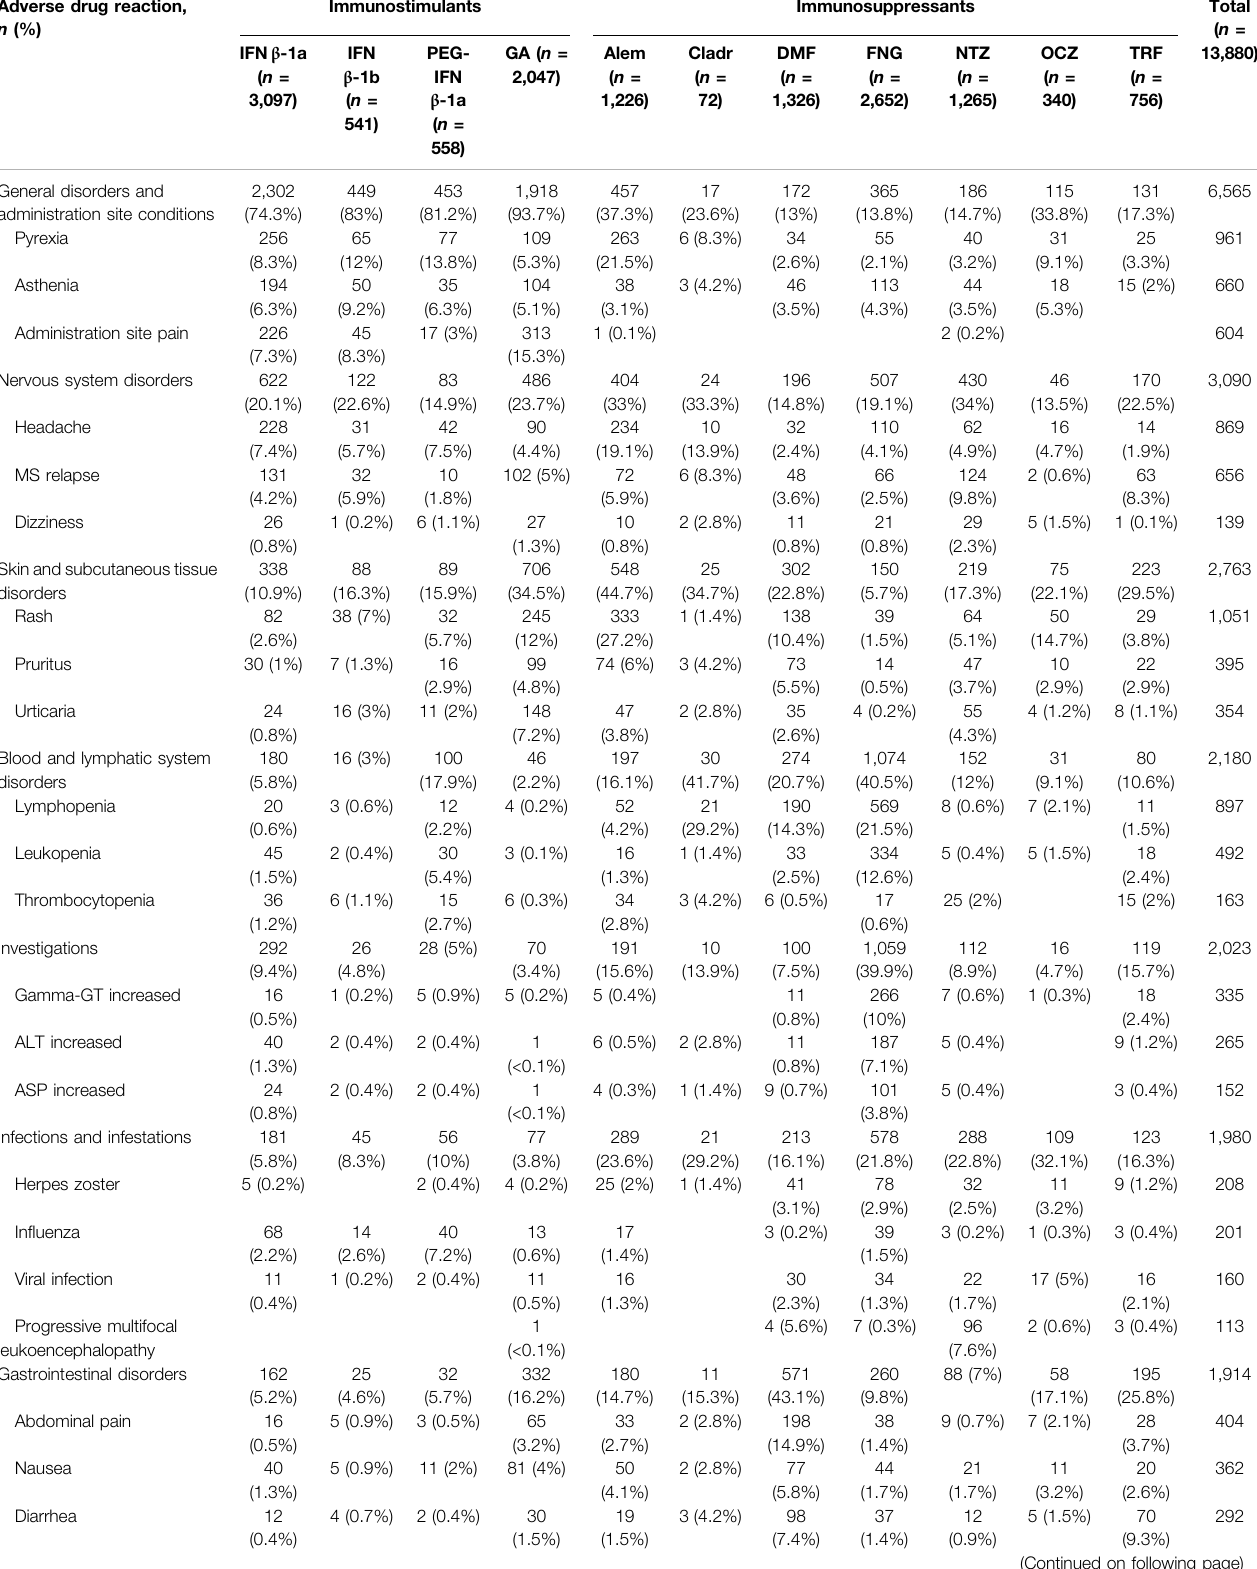
TABLE 3 | Descriptions of main ADRs associated with drugs for MS treatment and reported into the RAM